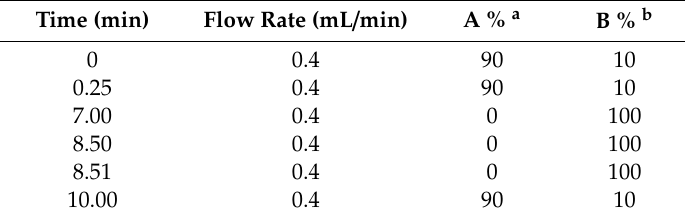
Table 1. Elution conditions for UPLC-MS / MS analysis